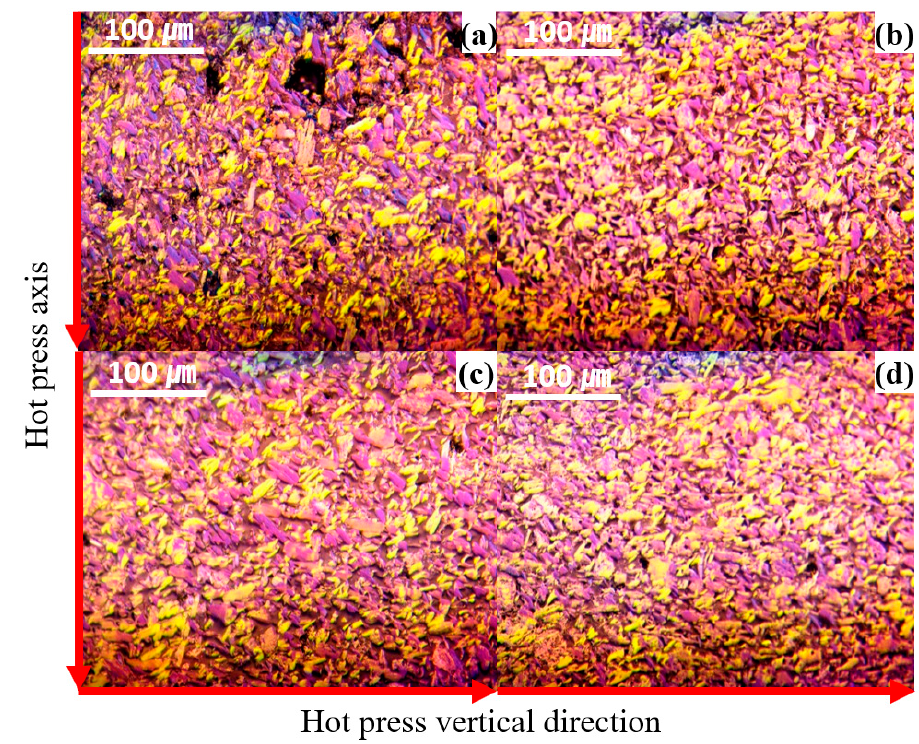
Figure 3. Optical structure of graphite block; ( a ) B_N-G, ( b ) B_5-G, ( c ) B_10-G, ( d ) B_20-G.